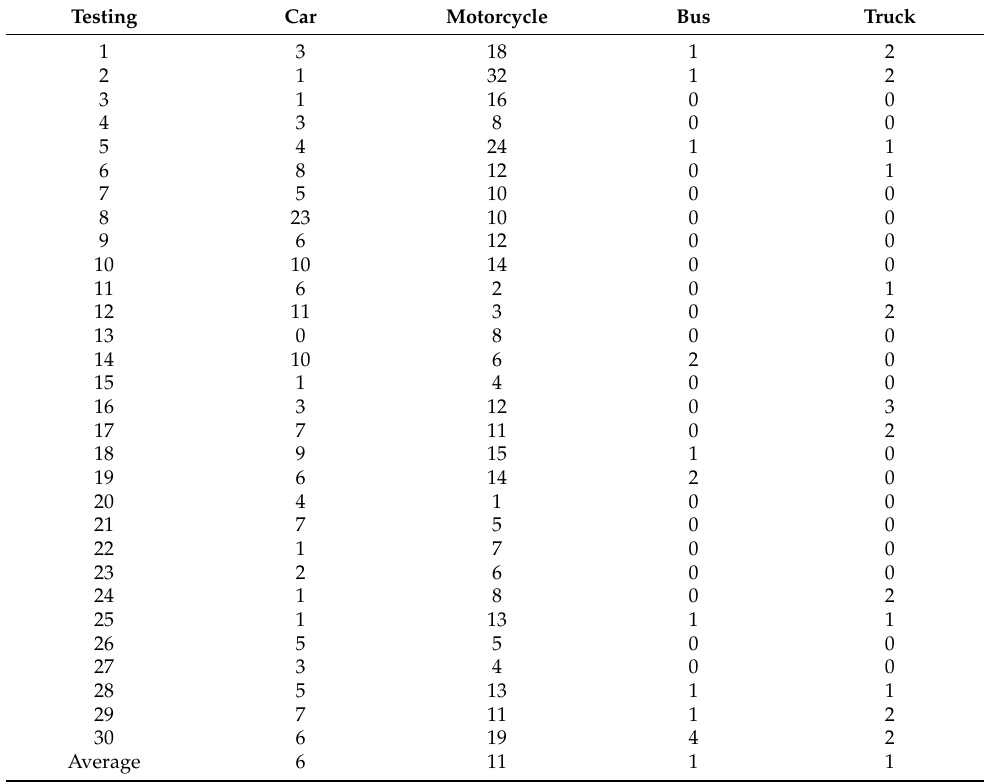
Table 14. Error rate in vehicle counting on Merdeka-Aceh Intersection. Testing Car Motorcycle Bus